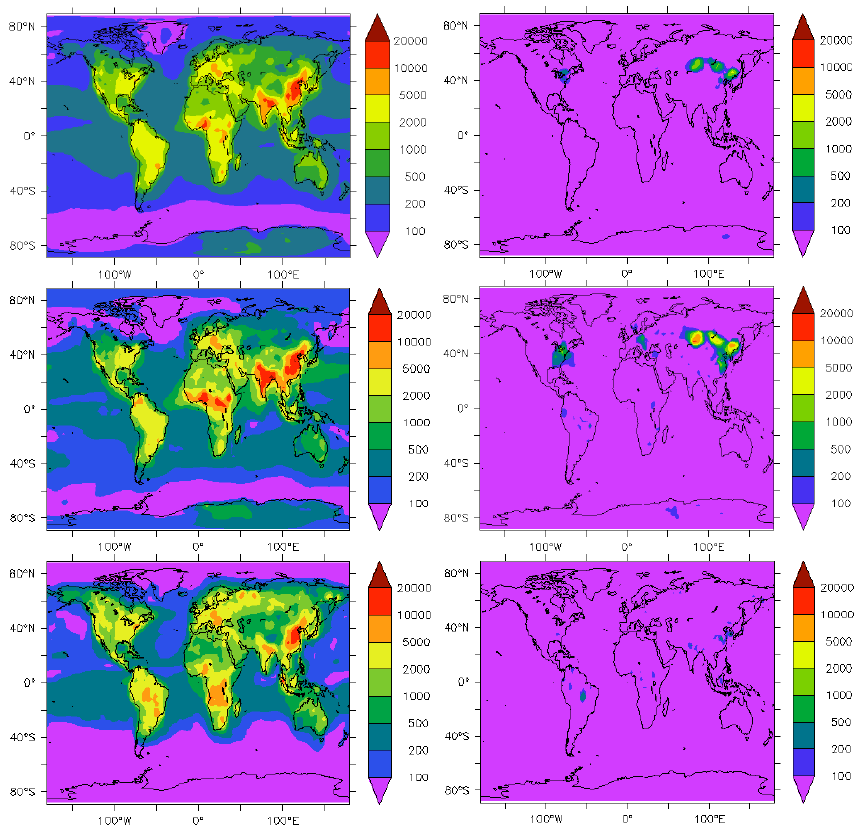
Fig. 9. Simulated mean aerosol number concentrations (cm − 3 ) near the surface for the mean annual (upper panels), boreal winter (January, middle panels) and summer (July, lower panels) conditions and the absolute changes (right panels) due to HONO enhancement in the model.